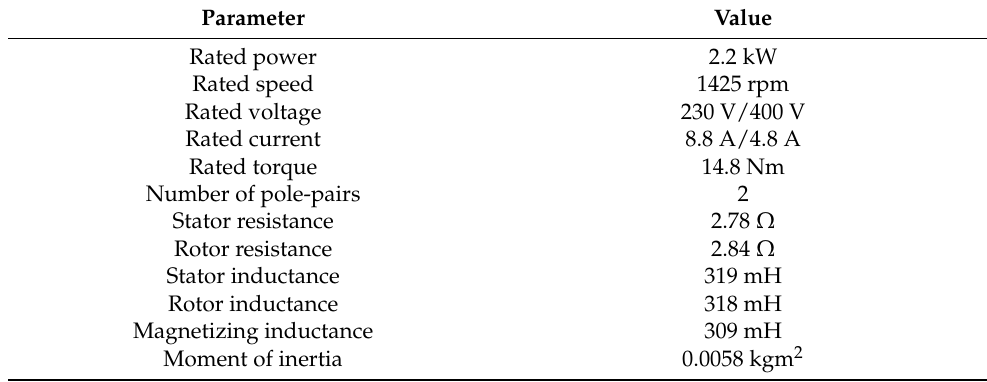
Table 1. Induction motor